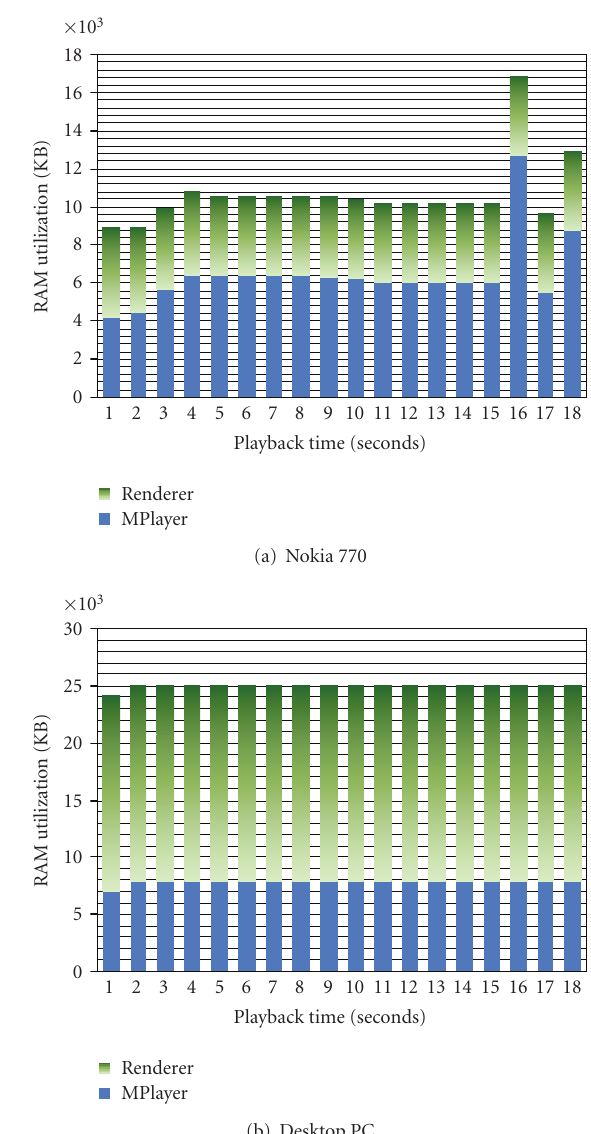
Figure 11: RAM utilization